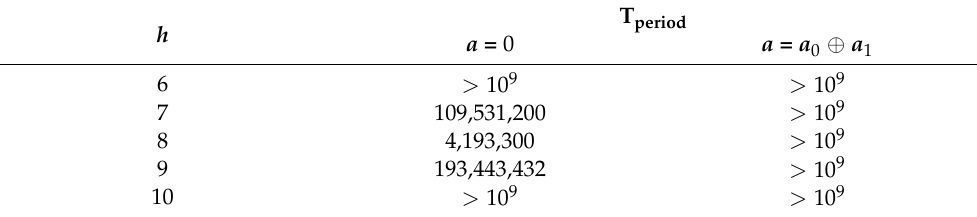
Table 3. Results of the investigation of the MAFG repetition period.